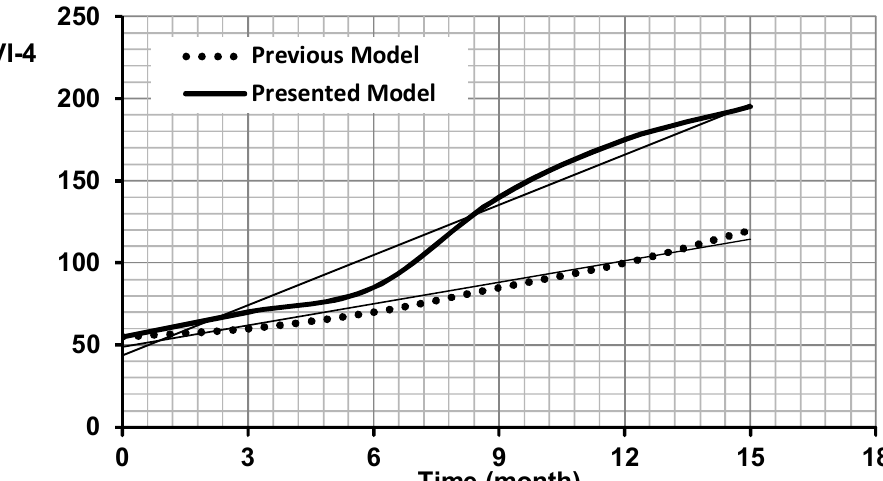
Fig. 7. Comparison between presented and previous KM implementation model for part four of the characteristics in case study (AVI-4)